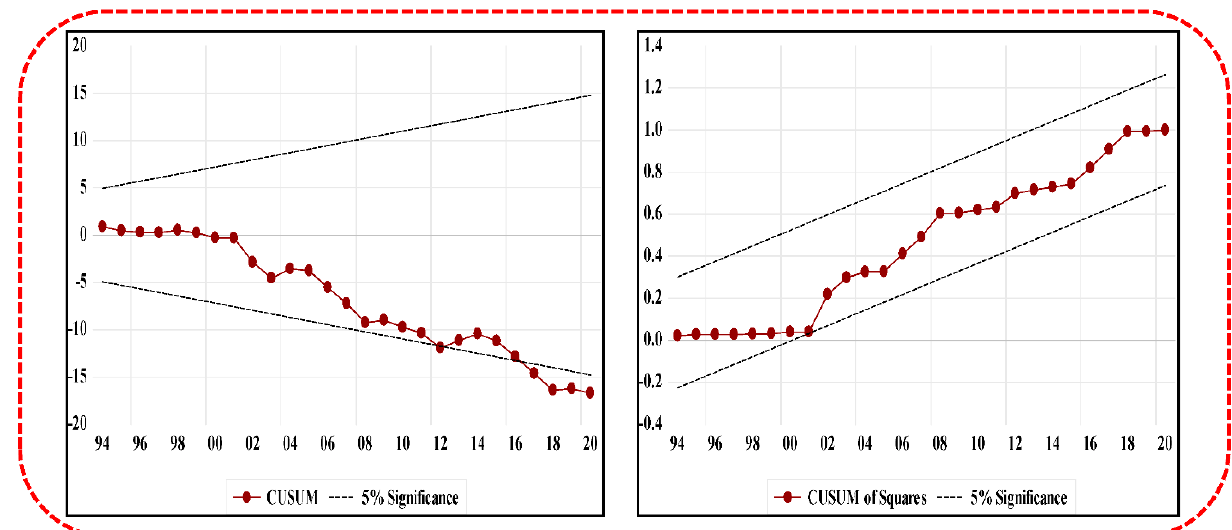
Figure 2. CUSUM–CUSUM square plots.